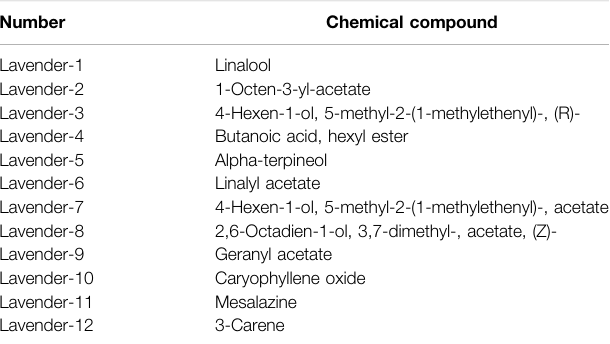
TABLE 3 | Molecular docking result of key components and corresponding key targets.